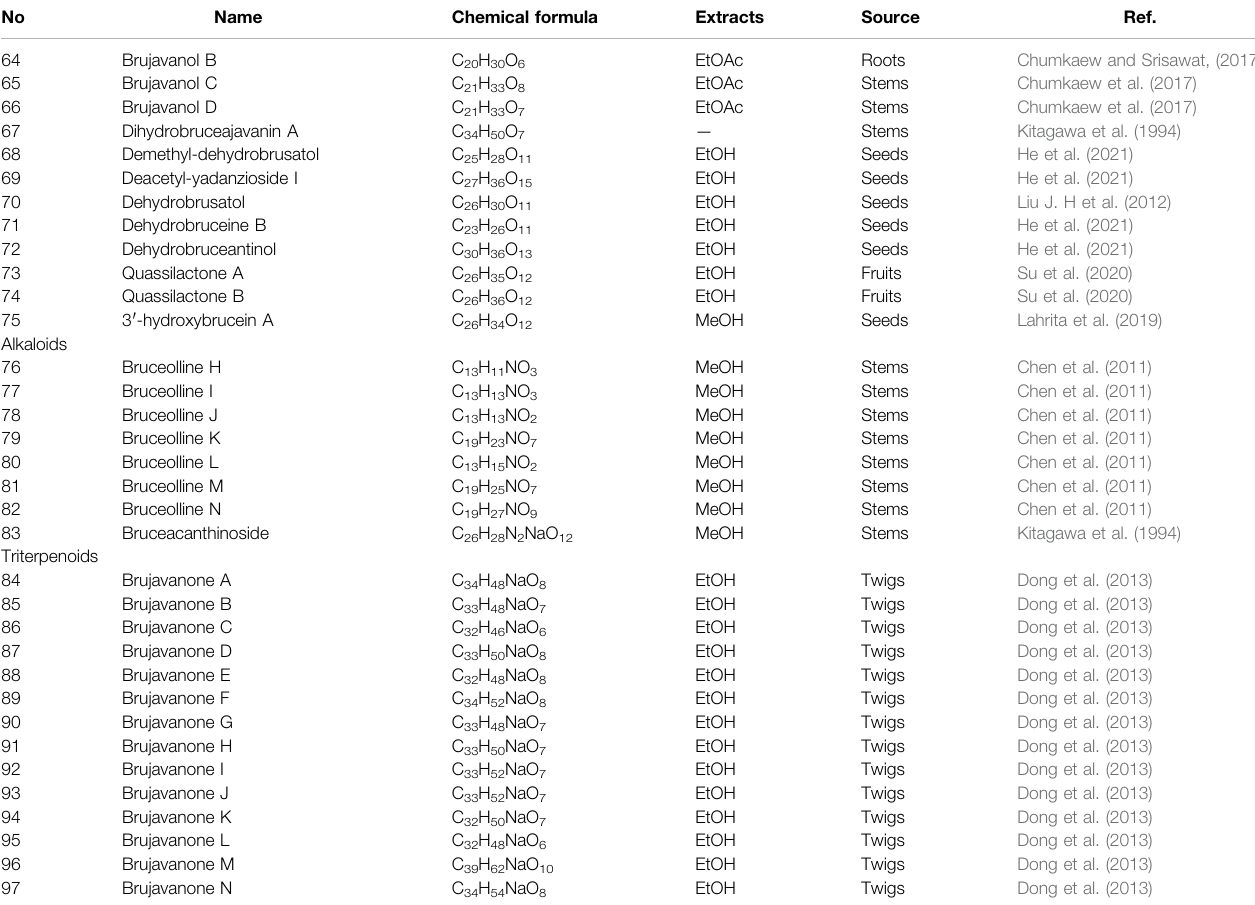
TABLE 1 | ( Continued ) The molecular formulae and source of the constituents isolated from B. javanica